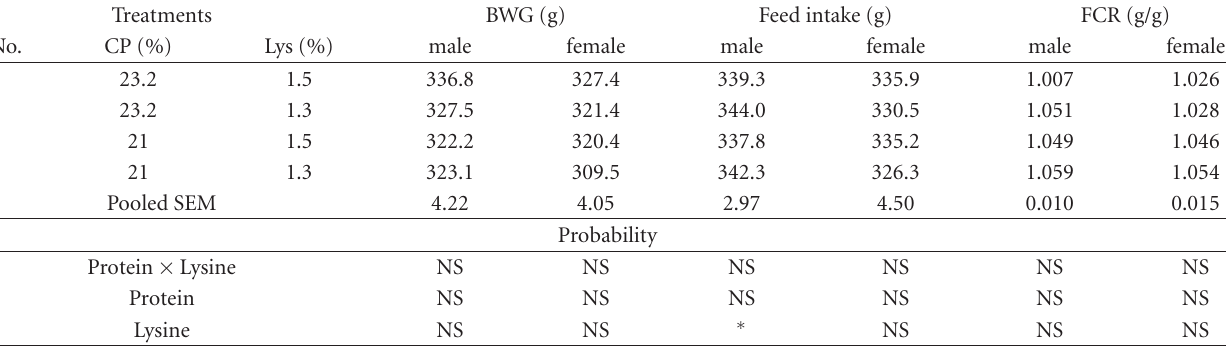
Table 5: E ff ect of feeding diets containing two levels of crude protein (CP) and lysine (Lys) on body weight gain, feed intake and feed conversion ratio of male or female broiler chicks at 10 d (Experiment 2-1).